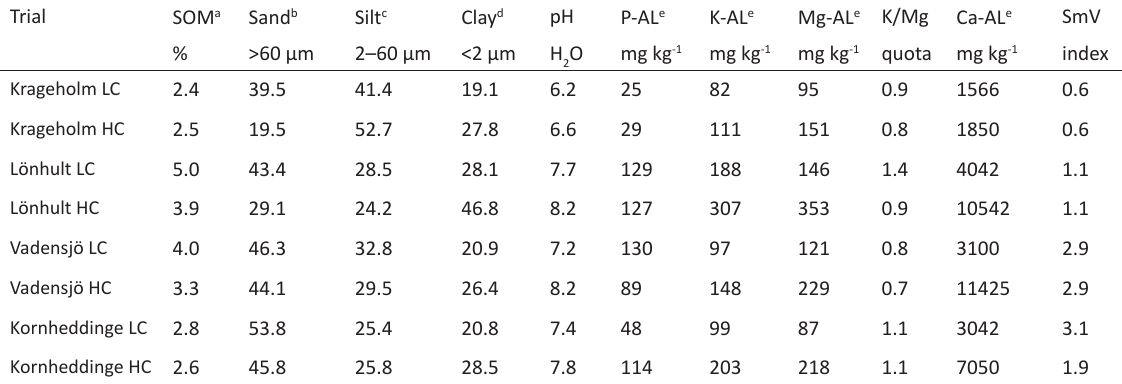
Table 3. Mean (of 12 plots) soil texture, soil organic matter (SOM), nutrient status and clay mineralogy (SmV index) in topsoil (0–20 cm) in the eight field trials prior to structure liming in August–September 2014, HC/LC = high/low clay soil at each